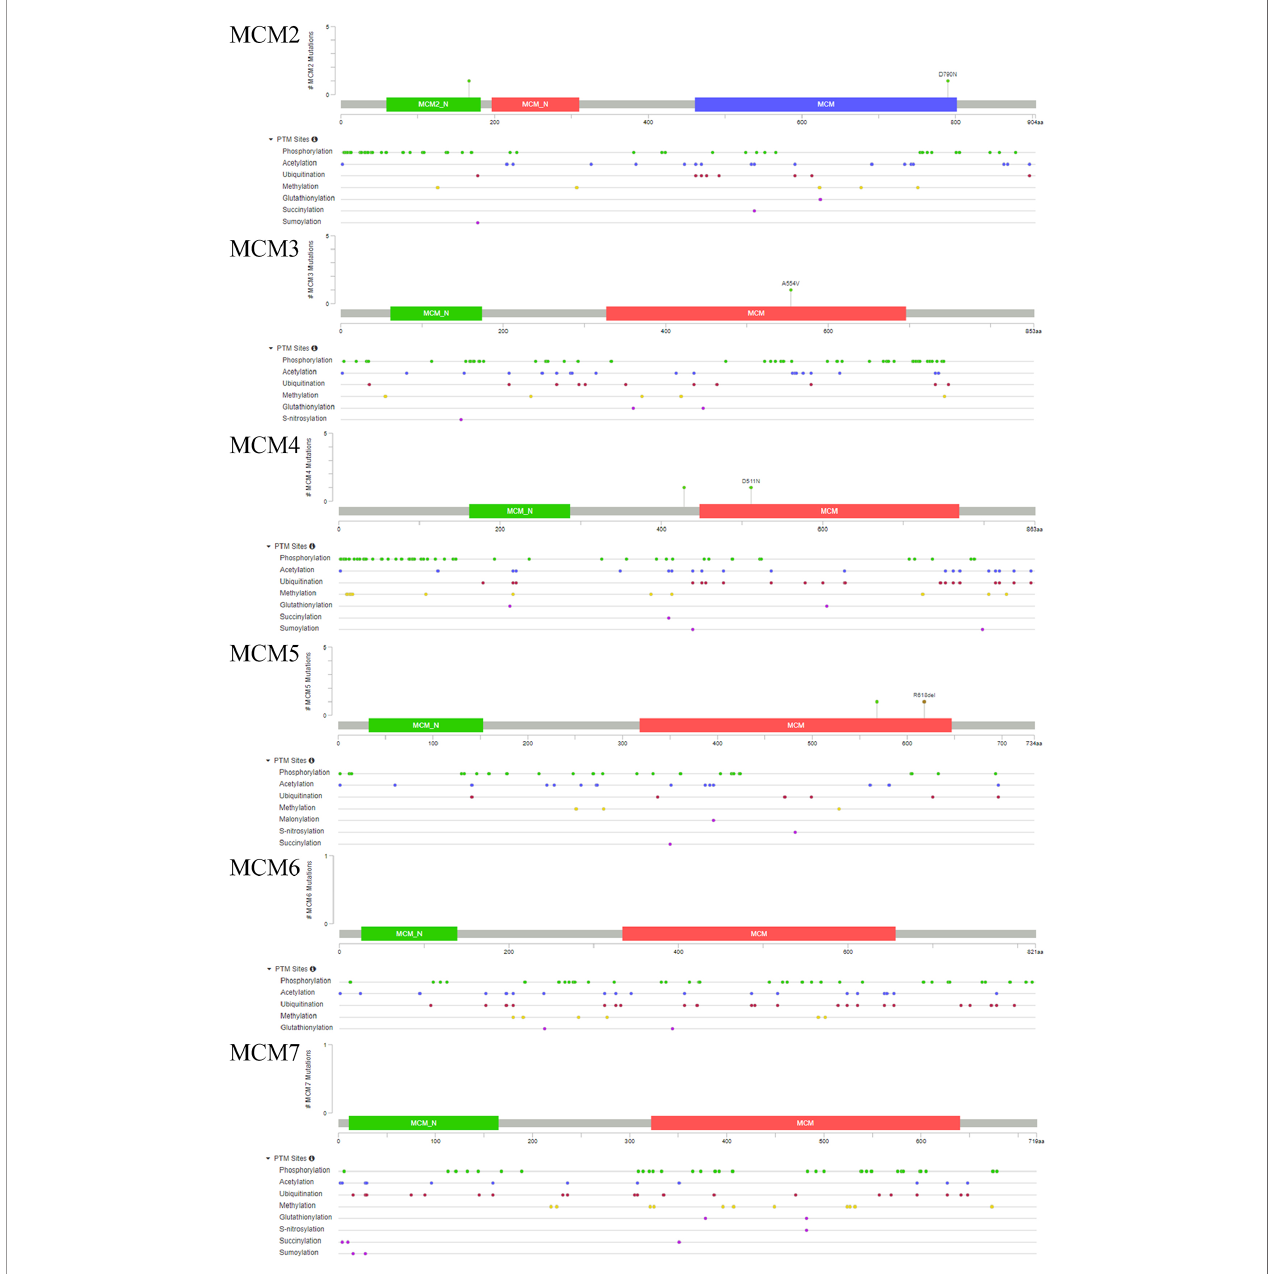
FIGURE 6 | Protein secondary structures of MCM2 –